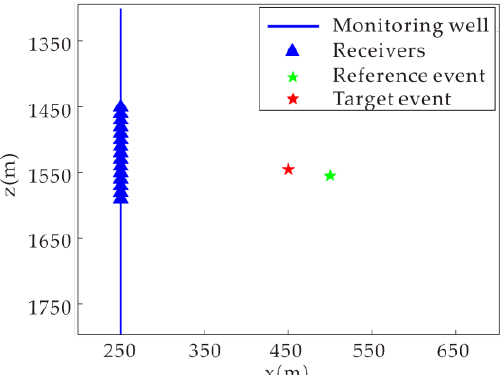
Figure 2. Downhole acquisition geometry of 2D homogeneous model. The x - and z -axes indicate the offset and depth directions, respectively.